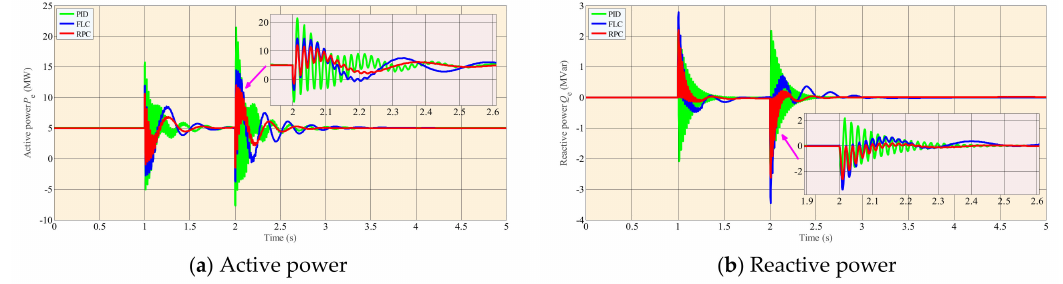
Figure 5. System responses obtained under a 35% voltage drop lasting 1 s at power grid with a constant wind speed of 12 m/s and fixed pitch angle of 15 deg. (operation type I). ( a ) active power; ( b ) reactive power speed.